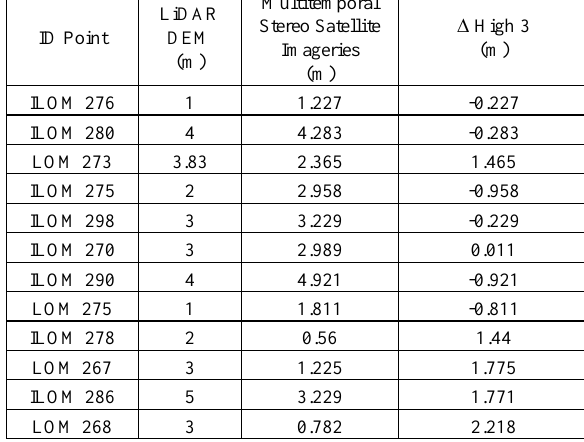
Table 4. Differences high value between Multitemporal Stereo Satellite Imageries and LiDAR DEM. RMSEz value calculation performed to determine the vertical accuracy of each DEM has produced. RMSEz calculation is done with 90% confidence range (LE90). Table 5 presents the results of RMSEz calculation and accuracy of each DEM that have been in